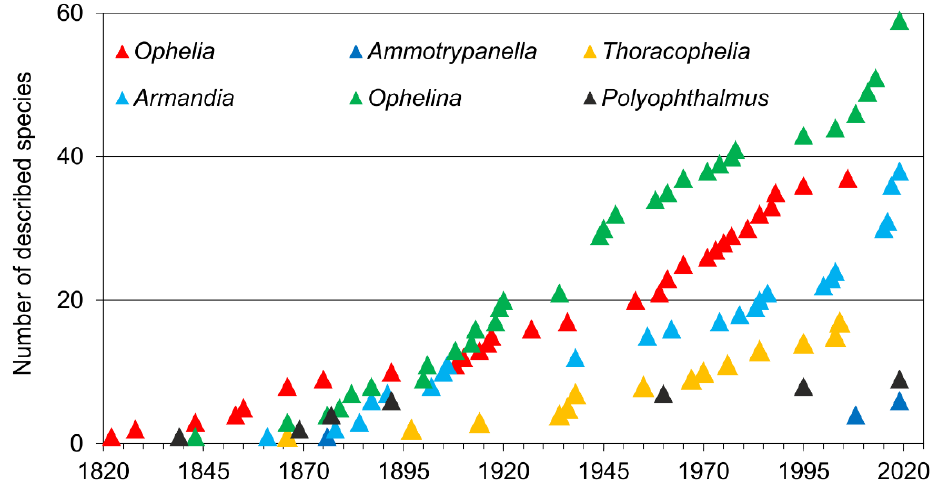
Figure 3. Number of described species (accumulated) of each opheliid genus (including Ammo- trypanella ) from 1820 to